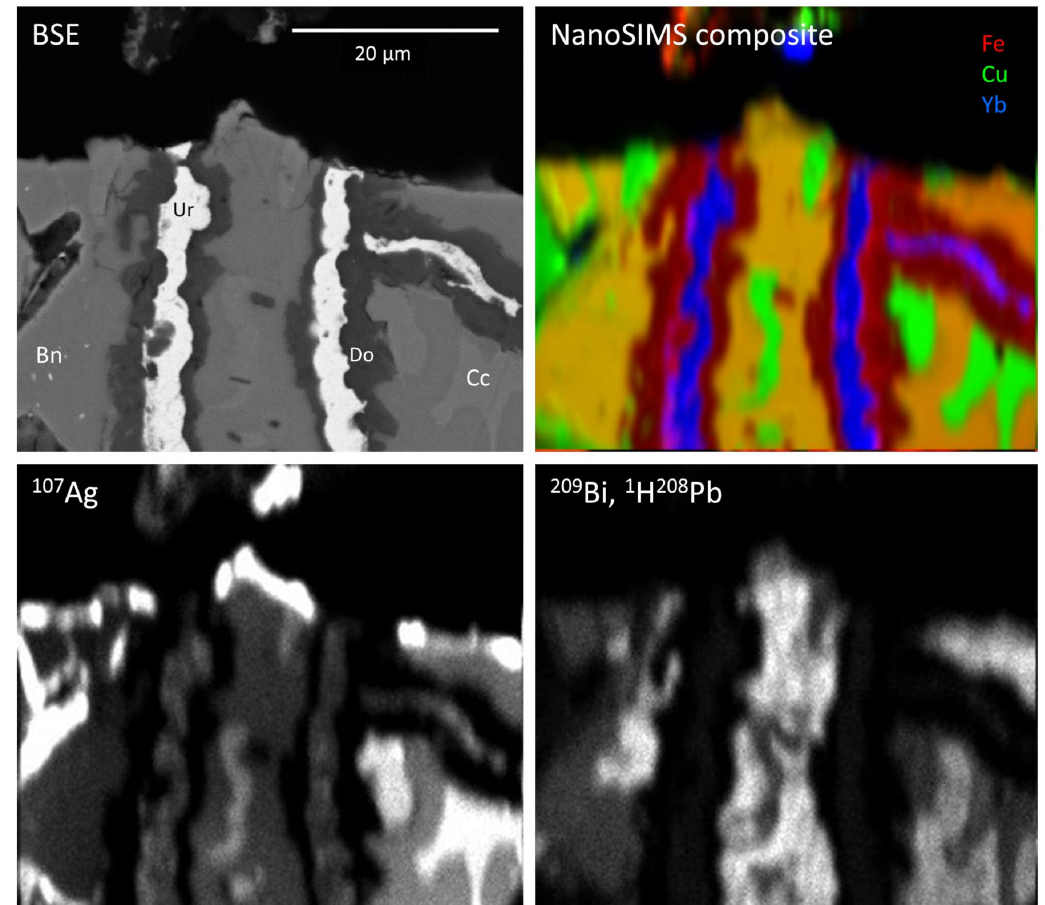
Figure 2. The BSE (top left) and nanoSIMS images of sample 01FC58 showing fracture fill uraninite (Ur) and dolomite (Do) within host bornite (Bn) and chalcocite (Cc). The nanoSIMS composite image combines Fe (red), Cu (green), and Yb (blue) maps. Note that orange is the result of a red and green overlap (bornite in this